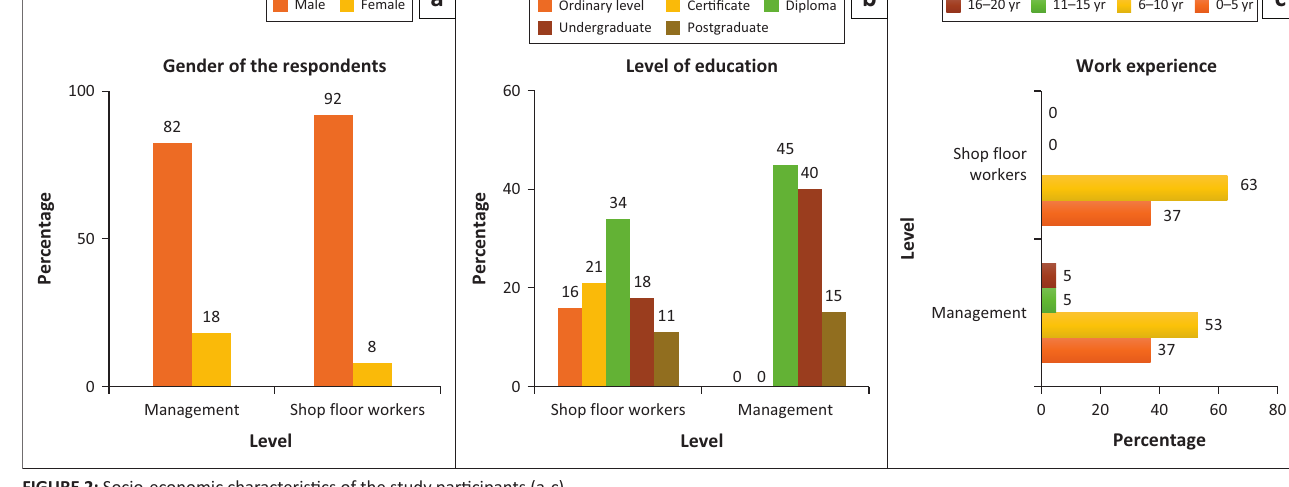
FIGURE 2: Socio-economic characteristics of the study participants